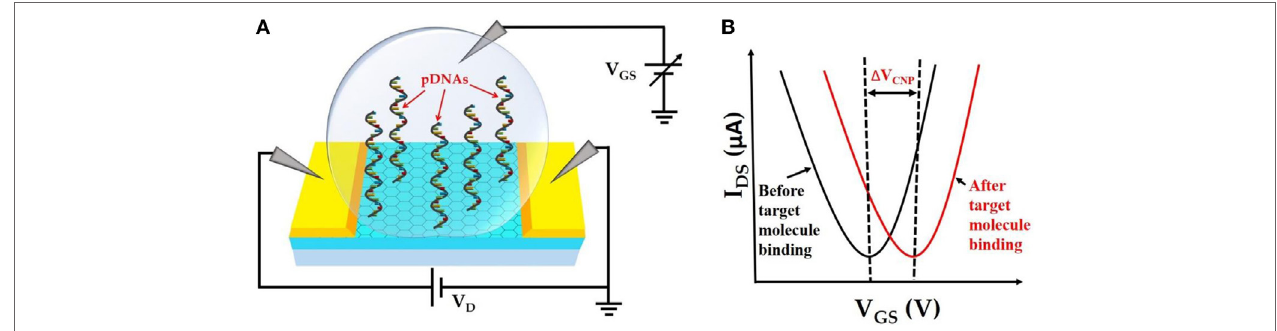
FigUre 1 | (a) . Schematic representation of top liquid-gated graphene field-effect transistor (GFET) device with anchored probe DNAs on the graphene channel surface. (B) I DS – V GS characteristics of GFET device before and after target molecule binding resulting in a detectable change in V CNP .